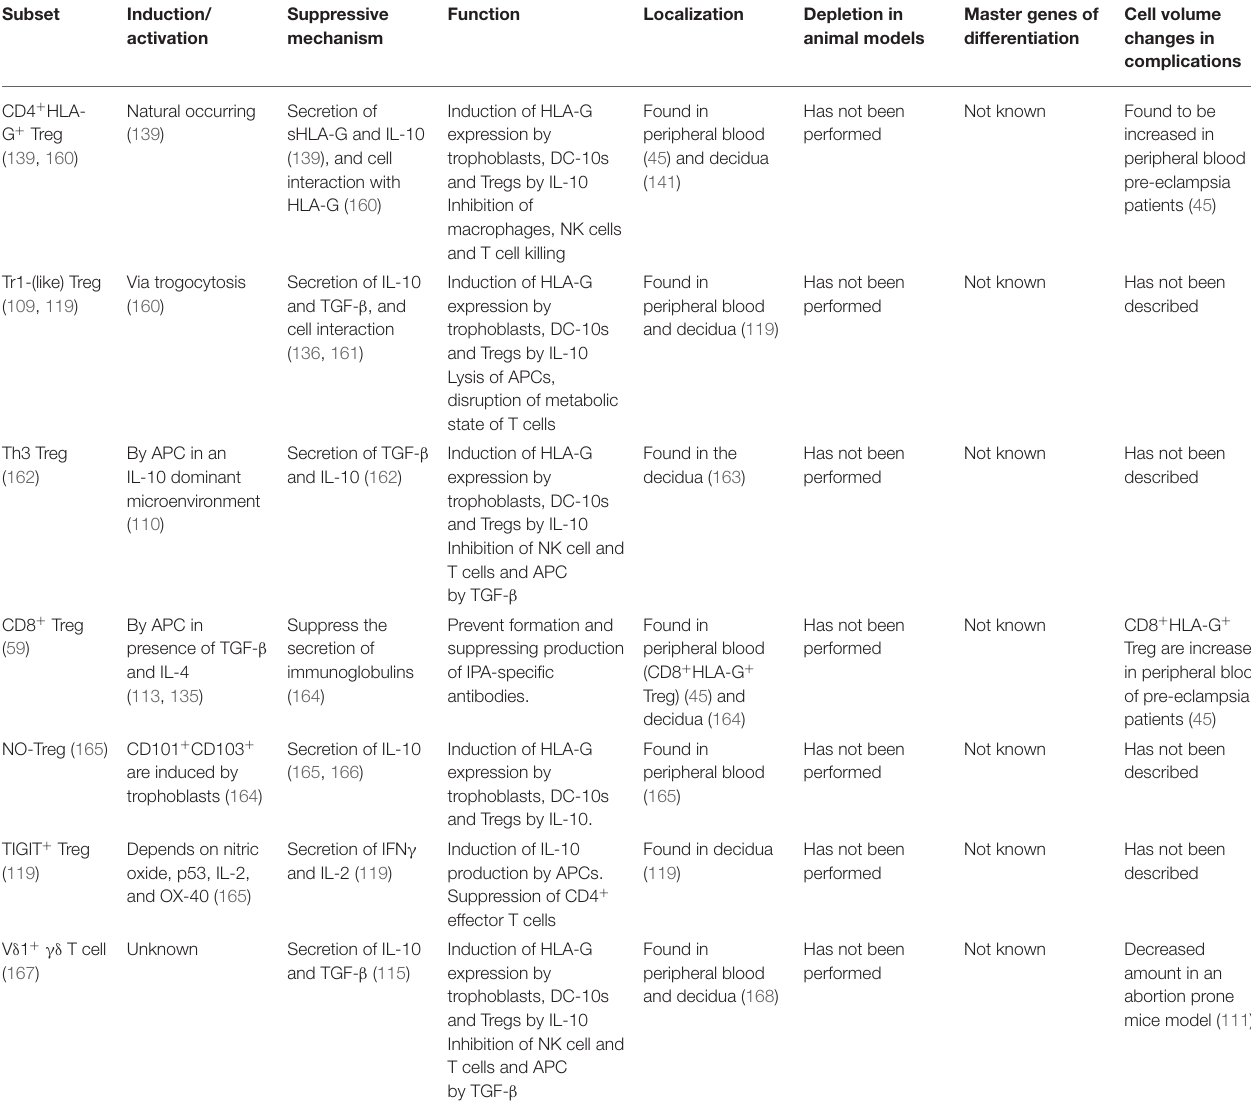
TABLE 1 | Overview of FoxP3 − immune regulating T cells discussed in this review, how they are induced or activated, their main suppressive mechanism and how they function, their localization, animal models depletion assays, master genes for differentiation, and cell volume changes in complicated pregnancies.